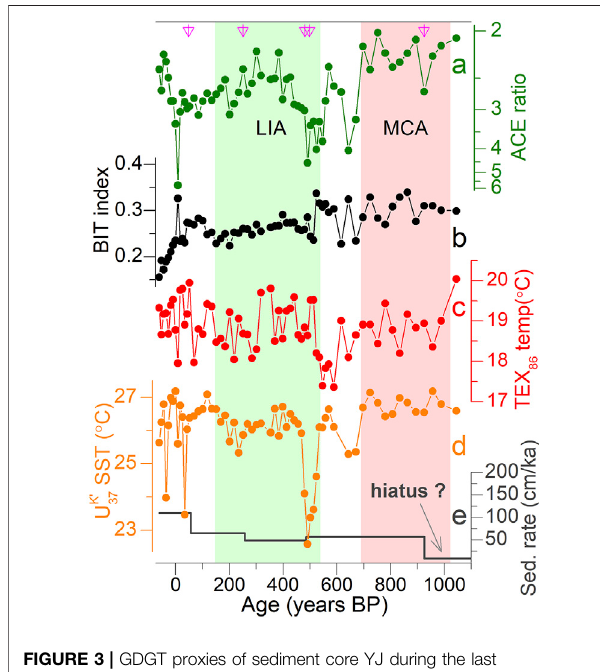
FIGURE 3 | GDGT proxies of sediment core YJ during the last millennium, for example, (A) ratio of archaeol to caldarchaeol (ACE) (higher values downward), (B) the branched and isoprenoid tetraether (BIT), (C) TEX 86 -basedtemperatures, (D) U K ′ 37 -SSTrecord,and (E) sedimentation rates (Zhang et al., 2019). Color bars outline the Little Ice Age (LIA, ∼ 150 – 550 years BP) (green) and Medieval Climate Anomaly (MCA, ∼ 700 – 1,100 years BP) (red), and triangles denote 14 C age control points.